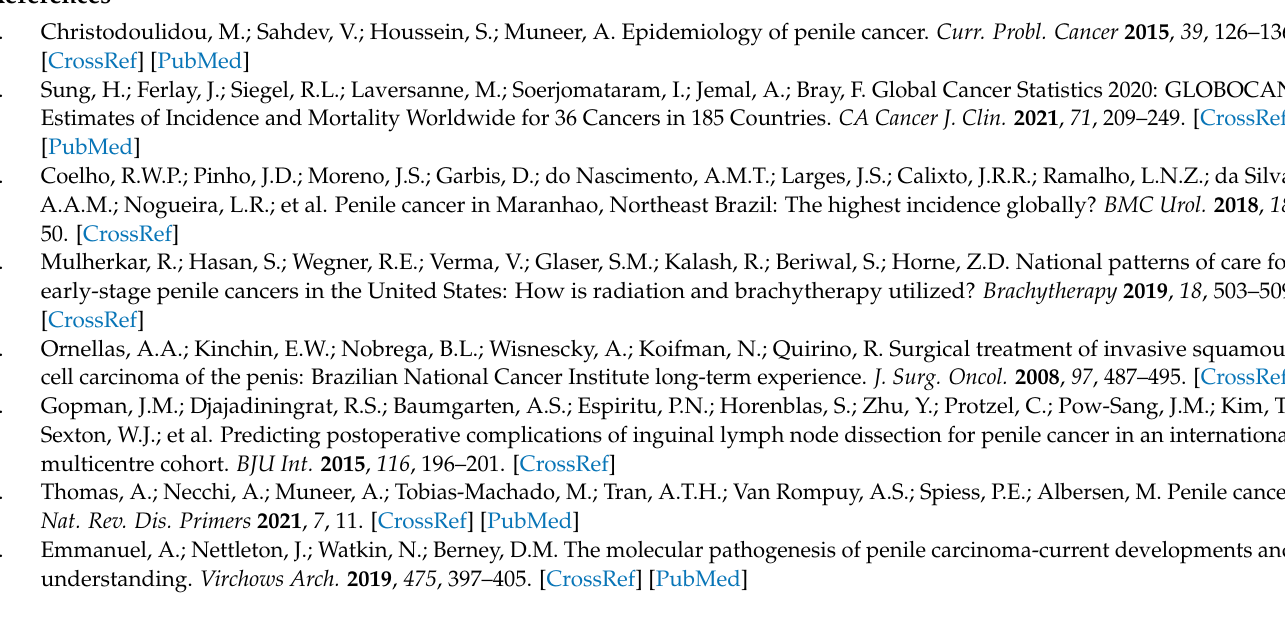
Table S6. List of Gene Ontology (GO) enriched pathways of differentially expressed genes detected by Biomark HD Fluidigm platform in the comparison between tumoral ( n = 24) and non-neoplastic tissues ( n = 24). Table S7. List of the 69 DEmiRs detected in the comparison of tumoral and non- neoplastic tissues in the microarray analysis with opposite expression levels relative to that of the 37 DEGs described as experimentally validated according to miRTarBase